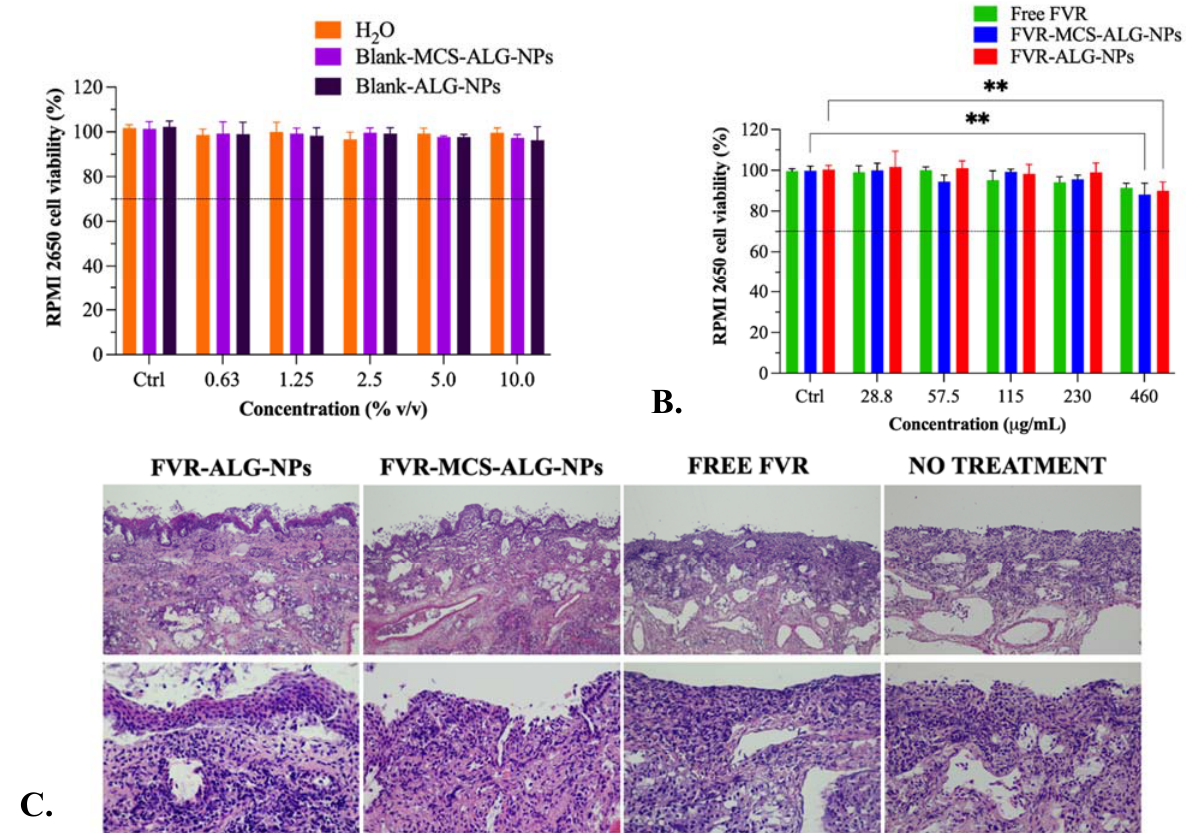
Figure 6. ( A , B ) Cytocompatibility study of NPs in RPMI 2650 human nasal epithelium, ( n = 3 independent experiments). The control cells containing media without any treatments were used to observe the cytotoxic effect of the test samples. The line signifies the lower limit for safety assessment (>70% viability) based on the ISO 10993-5 criteria [38]. ** p <0.001 compared to the control; ( C ) Histopathology of porcine nasal mucosa shows no significant lesions after 1 h of exposure to treatments viewed under low (top row) and high (bottom row) magnifications.